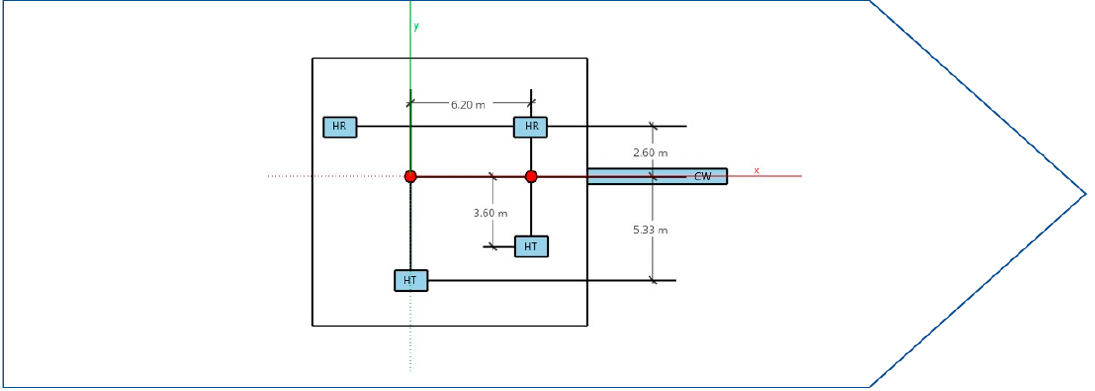
Figure 9. The layout of the drilling floor.